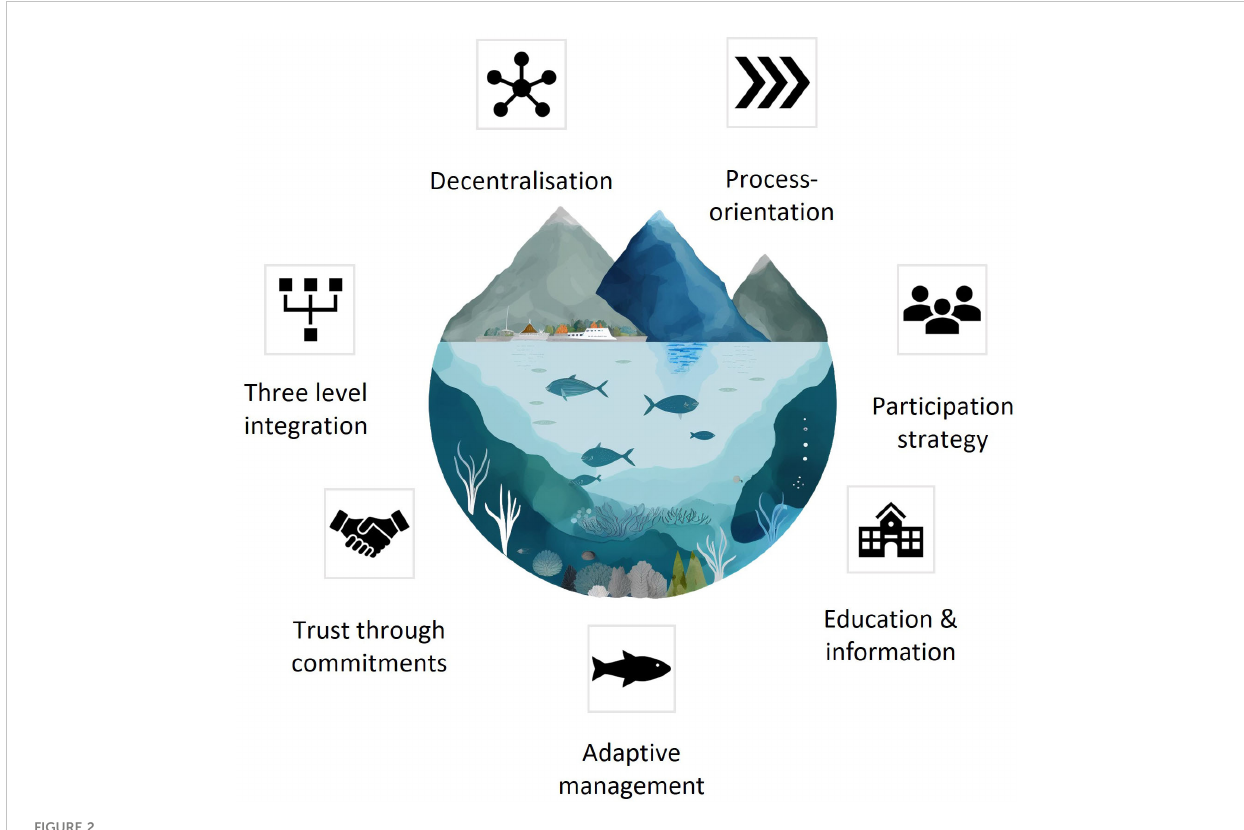
FIGURE 2 Recommendations for future iterations of Icelandic